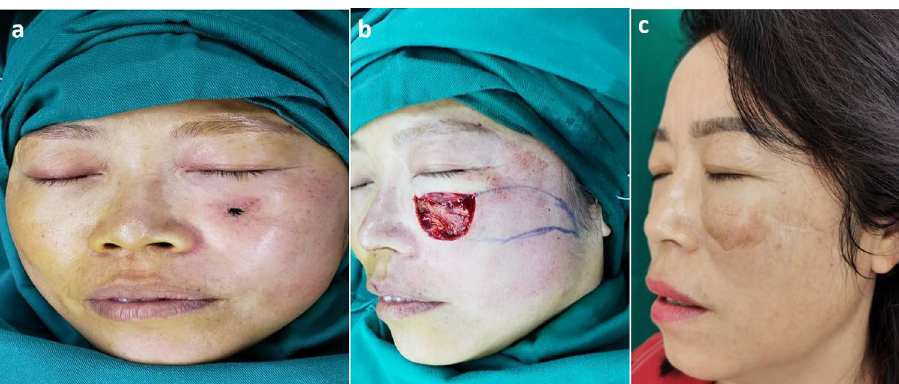
Figure 3. ( a ) A 48-year-old woman had a basal cell carcinoma of the left lower eyelid. ( b ) The tumor was extensively excised, and the flap was designed. ( c ) Good appearance and normal function of the eyelid was obtained at the long-term follow